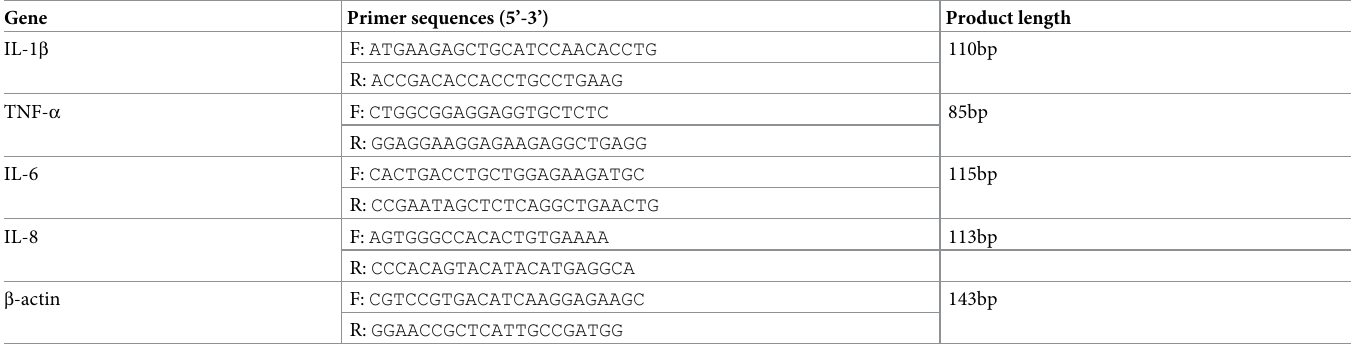
Table 2. The primers for qPCR.